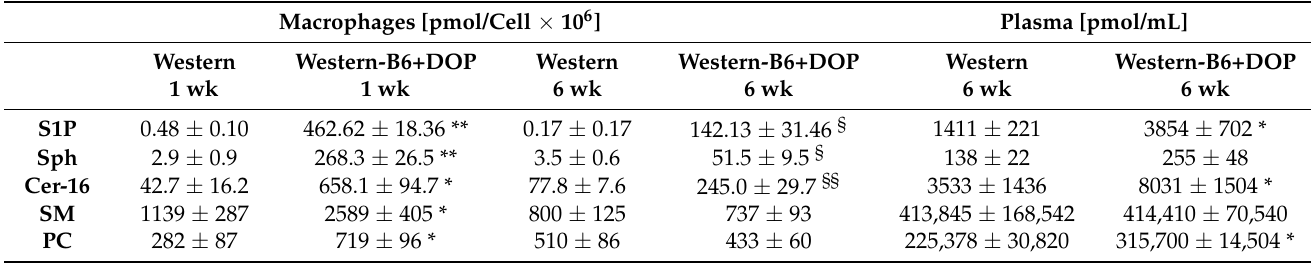
Table 1. Altered sphingolipid content in macrophages and plasma following S1P lyase